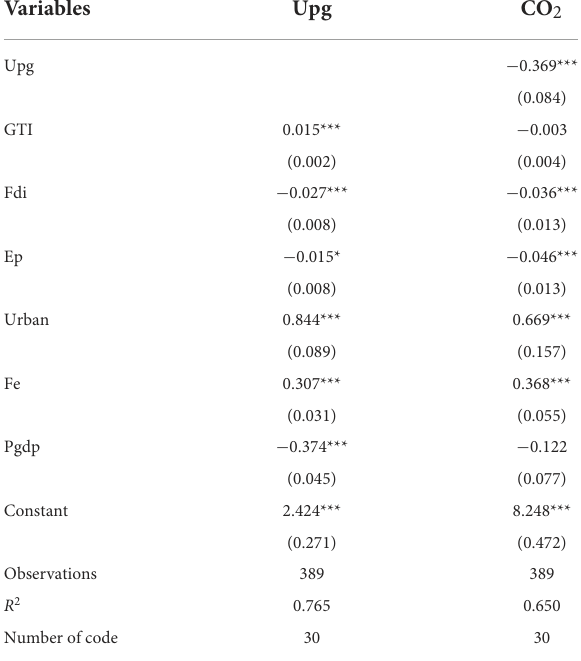
TABLE 4 Mediating effect